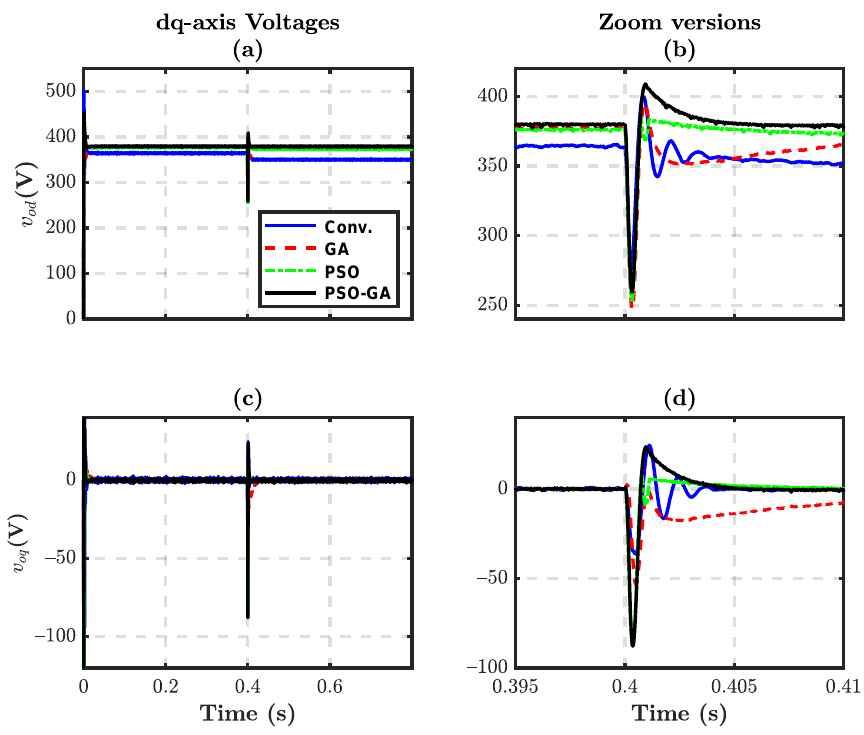
Figure 16. The dq -axis inverter output voltage with different designed parameters: ( a ) d -axis voltage;